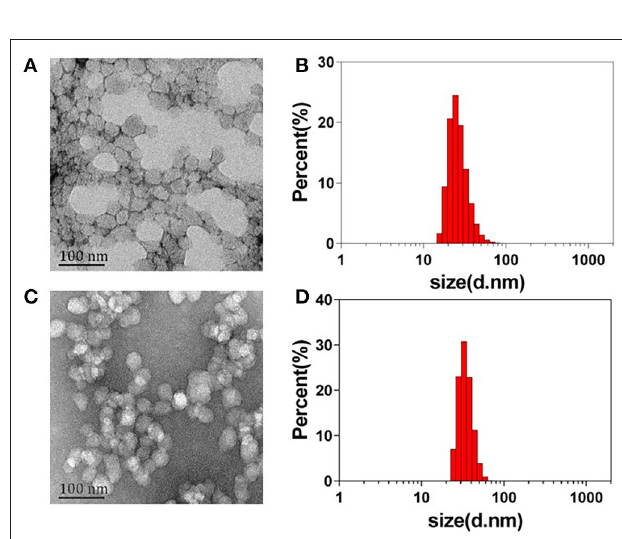
FIGURE 1 | The morphology and size distribution of nanoparticles. (A) The TEM image of ABN@HA-sese-Ce6 NPs; (B) Hydrate particle size